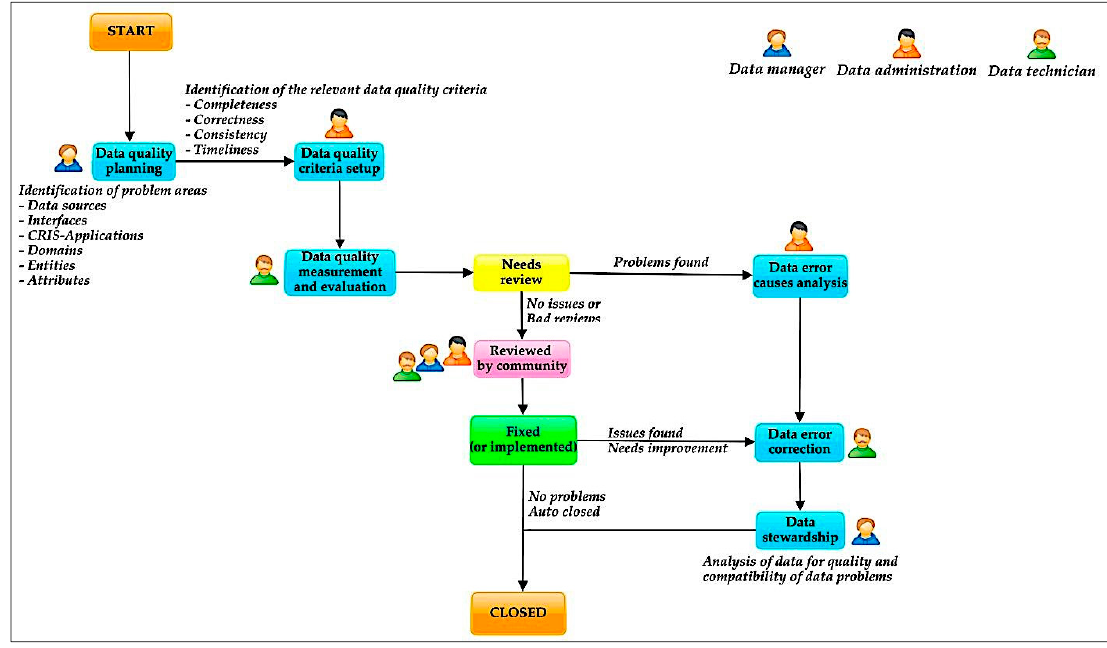
Figure 12. Process flow for managing and monitoring problem records in the context of CRIS.